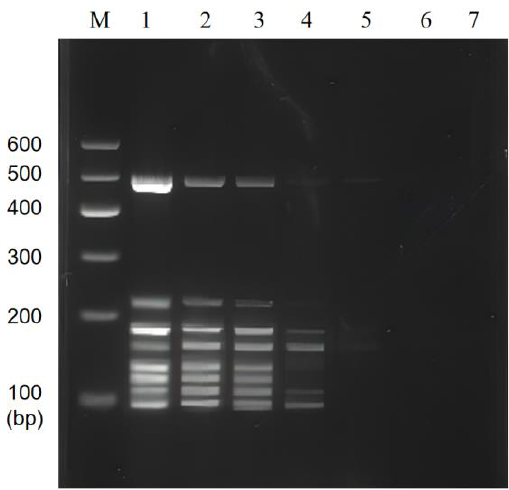
Figure 5. Results of multiplex PCR sensitivity. Lane M: DNA marker B 600; Lane 1~7: Mixed DNA was 1~10 − 6 times the original concentration.